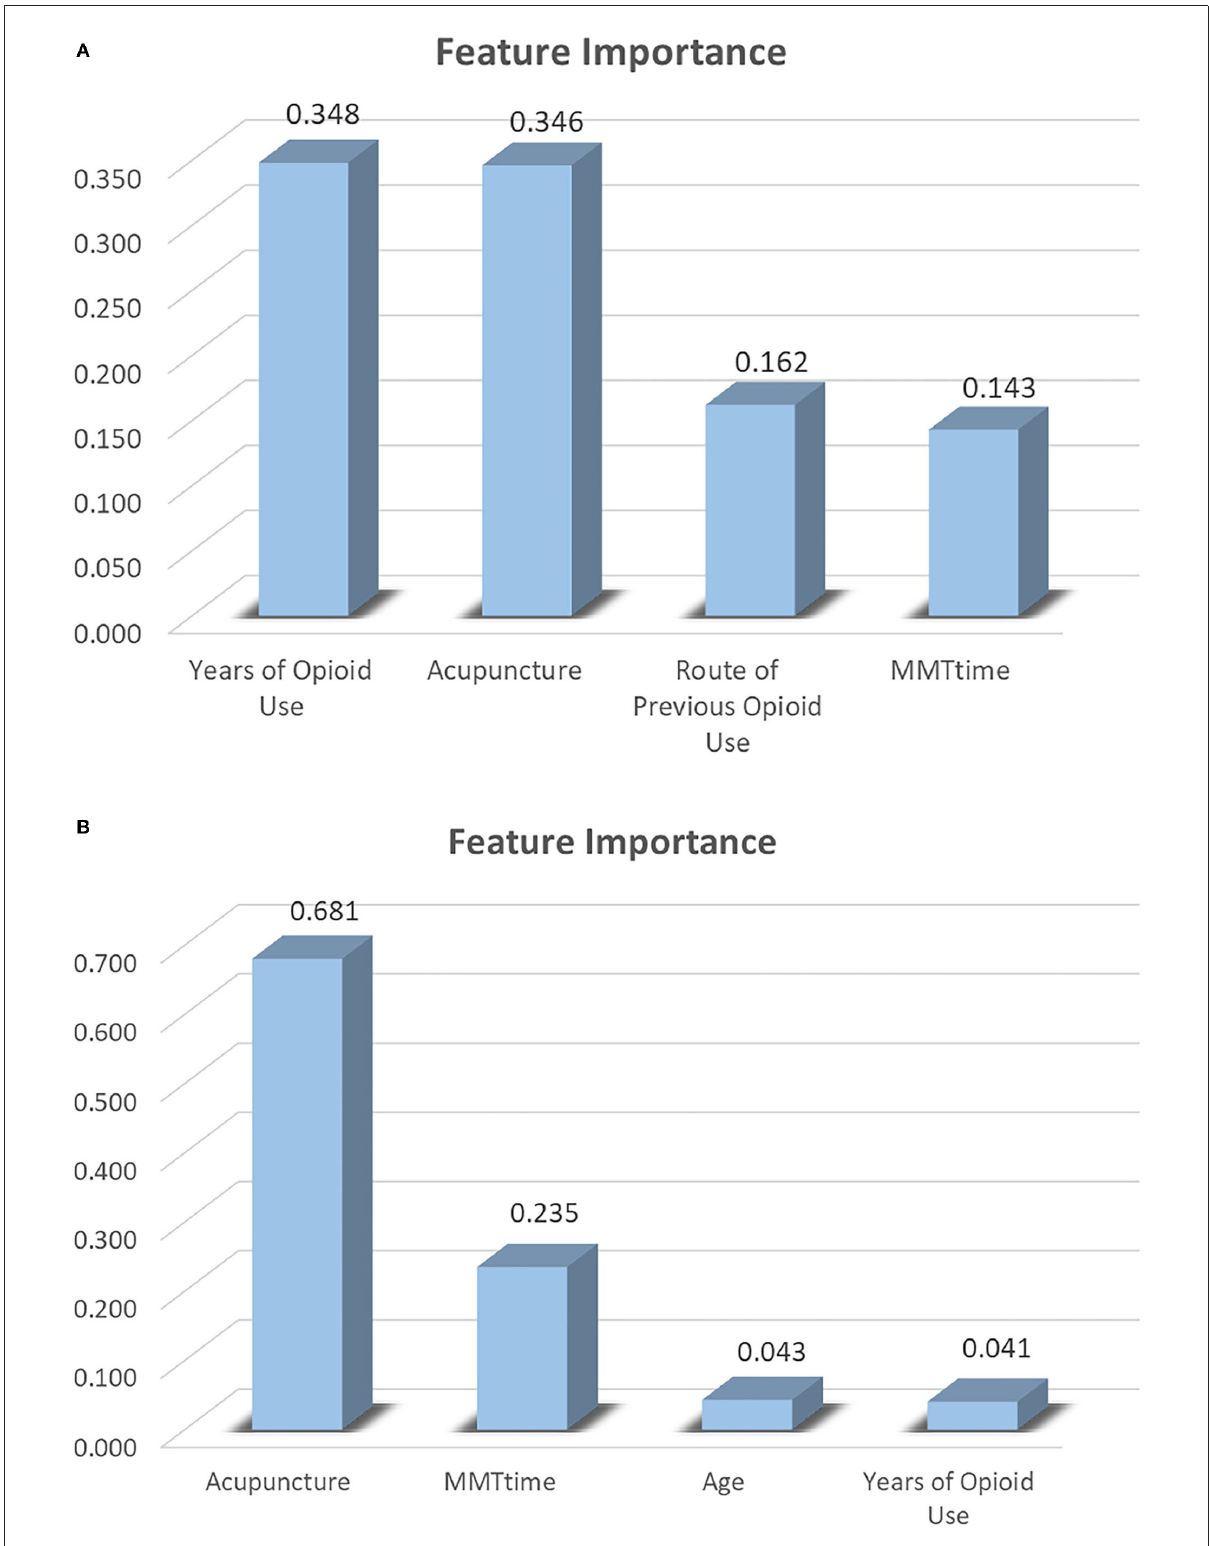
FIGURE4 Feature importance. (A) Methadone dosage efficacy. (B) VAS score